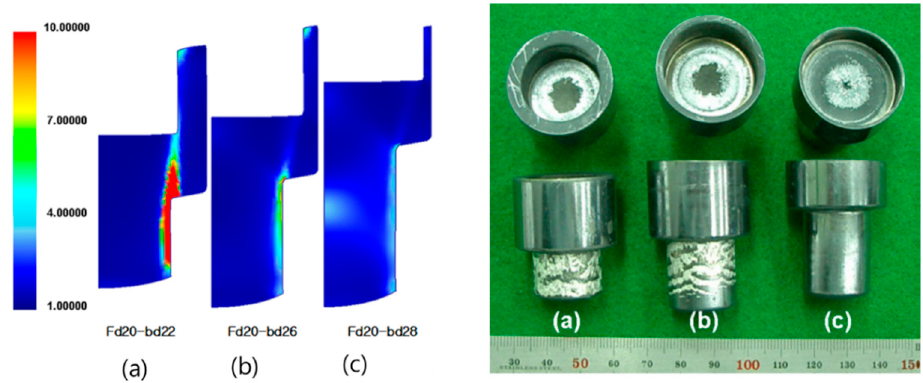
Figure 5. Distribution of predicted damage and experiments, described in Reference [13] for BER of ( a ) 2.16; ( b ) 4.02; ( c ) 7.75 under the punch speed of 2 mm/s and temperature of 200 °C.